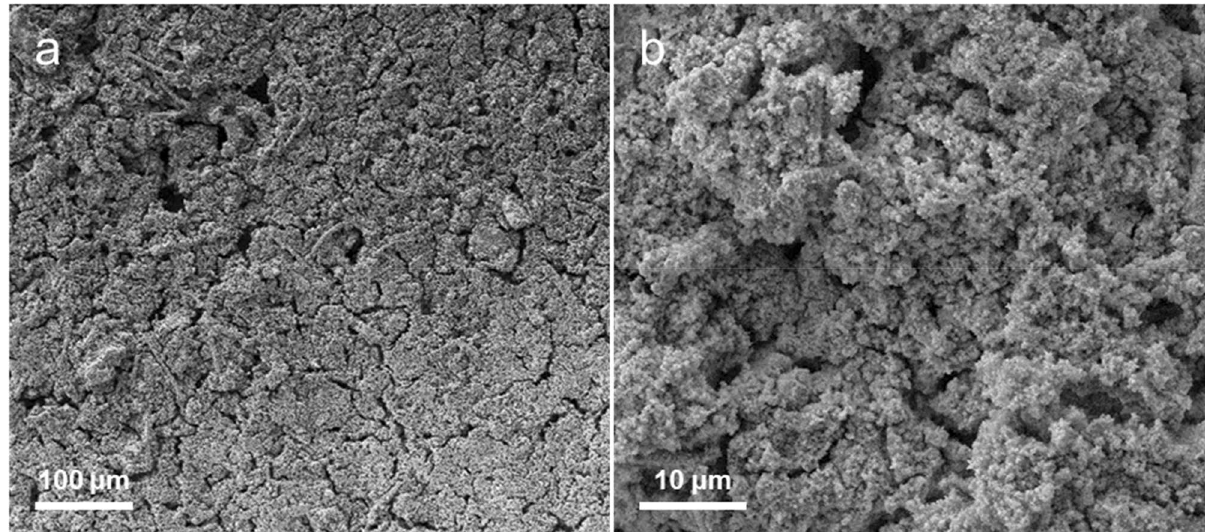
Figure 6. ( a , b ) SEM images at different magnifications of NBC@MWCNTs electrode at fully charged state after 5000 repeated electrochemical cycles under a constant current density of 5 A g −1